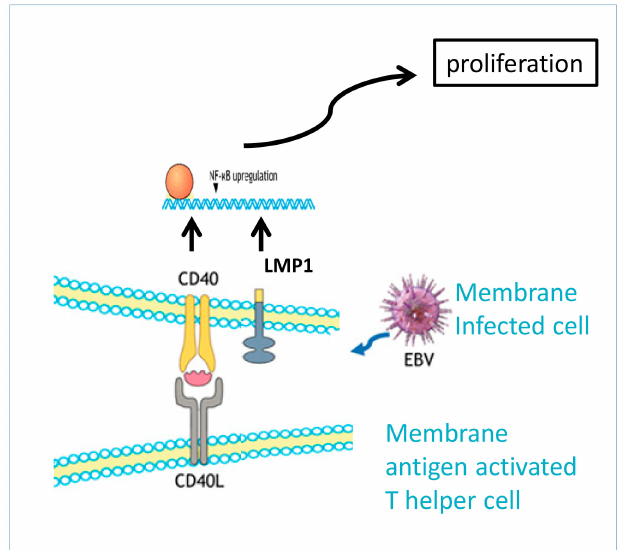
Figure 1. B-cells and Reed–Sternberg cells (HRS) express on their own membrane the CD40 receptor, which binds the CD40 ligand (CD40L) on activated helper T cells. The interaction activates a signal cascade leading to B-cell proliferation through nuclear kappa-light-chain-enhancer of activated B cells (NF-kB)-mediated e ff ector functions. CD40 / CD40L interaction also activated deaminase enzyme, responsible for the Ig class exchanges. The Epstein-Barr virus (EBV) latent membrane protein 1 (LMP1) is expressed in EBV latency II stage, which is a characteristic of Hodgkin lymphoma (HL). LMP1 acts as a dysregulated mimic of CD40, inducing enhanced cell activation and